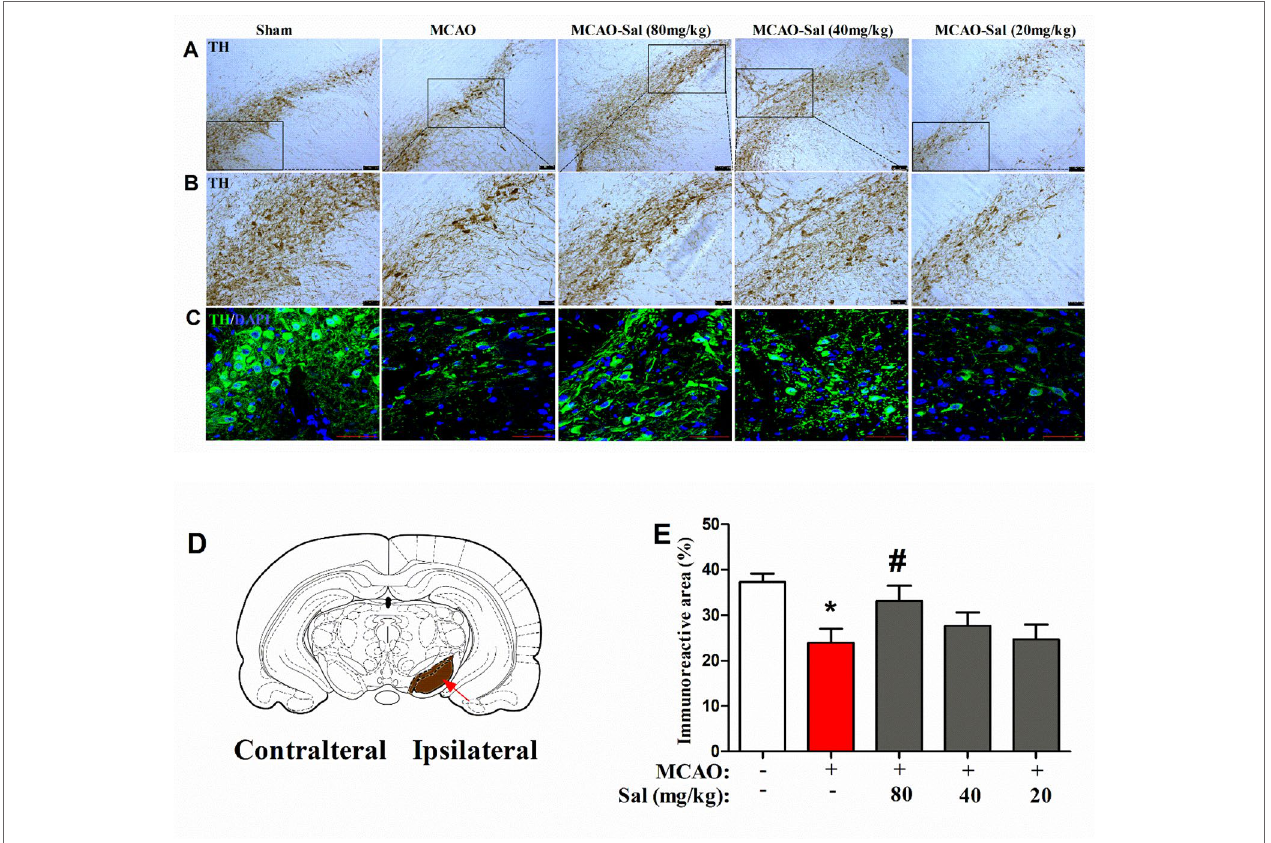
FIgURE 7 | Effects of salidroside on TH immunoreactivity in the SNpc after MCAO in rats. (a , B) TH immunohistochemical staining in the dopaminergic mesencephalic nuclei of the ipsilateral SNpc. Scale bar , 100 µm (a) and 50 µm (B) . (C) TH immunofluorescence staining in the dopaminergic mesencephalic nuclei of the ipsilateral SNpc. Scale bar , 50 µm. (D) Schematic diagram of rat brain Arrow indicates SNpc. (E) Immunoreactivity area percent of TH-positive expression in the SNpc after cerebral ischemia/reperfusion in rats. Values are all represented as the mean ± SEM ( n = 5 rats per group). * p < 0.05 compared with the sham group; # p < 0.05 compared with the MCAO group. MCAO middle cerebral artery occlusion, SEM standard error of the mean, SNpc substantia nigra pars compacta, TH tyrosine hydroxylase.